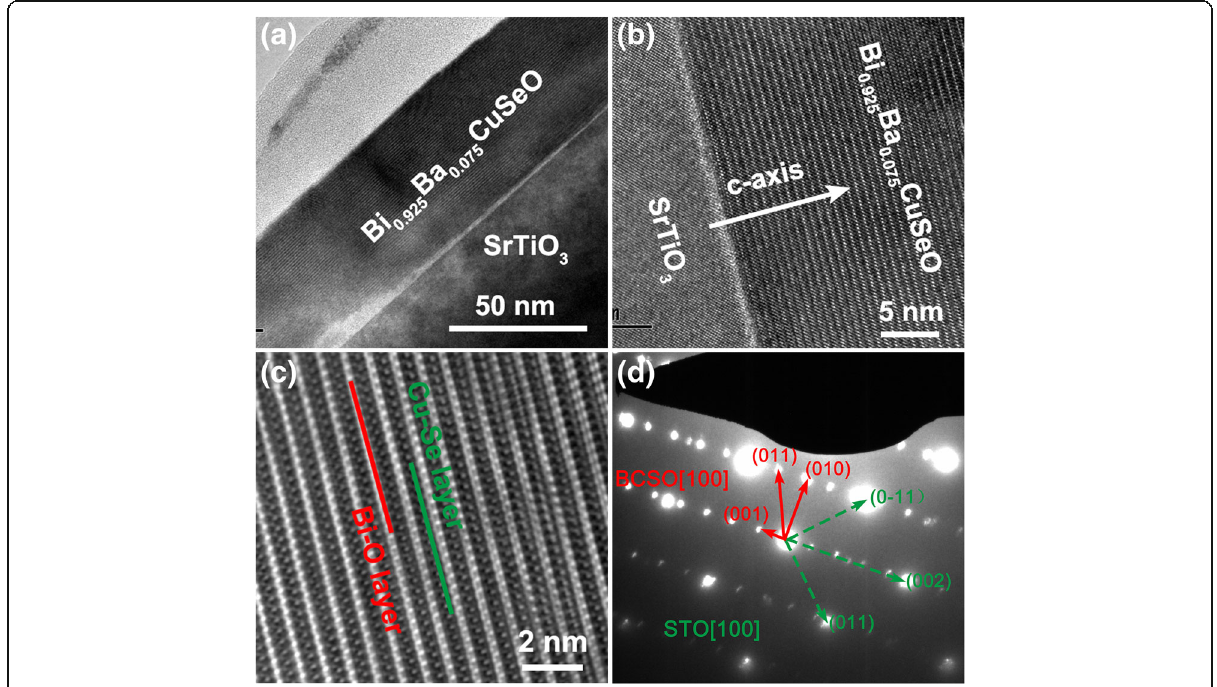
Fig. 2 a Low- and ( b ) high-magnification cross-sectional TEM image of a Bi 0.925 Ba 0.075 CuSeO film on SrTiO 3 (001) substrate. c The magnified HRTEM image of the film part. d The corresponding SEAD pattern of the Bi 0.925 Ba 0.075 CuSeO/SrTiO 3 cross section. The electron beam incident direction in a – d is all along the [001]